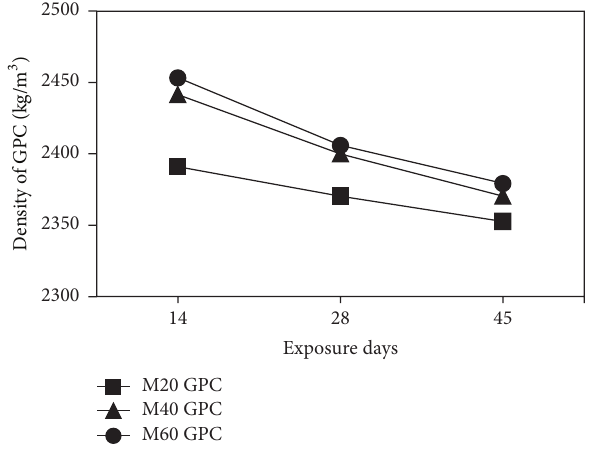
Figure 7: Density of GPC exposed to magnesium sulphate